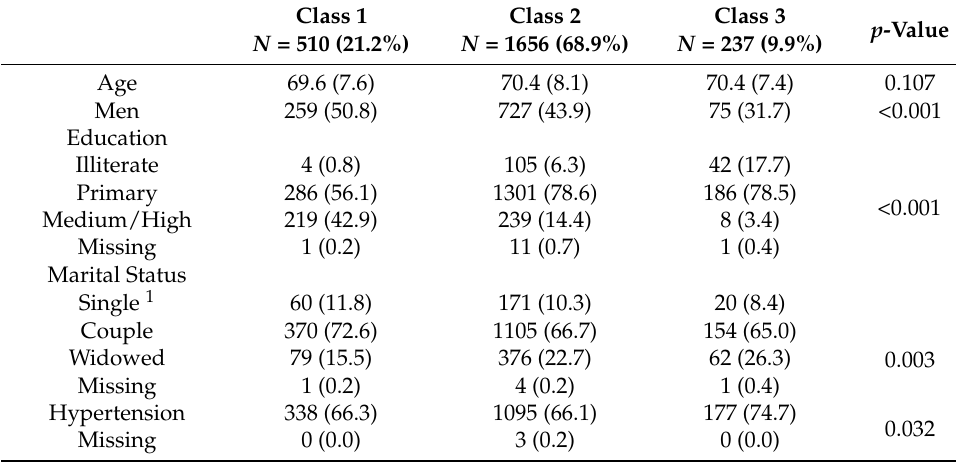
Table 3. Baseline characteristics of individuals in Classes 1 – 3.